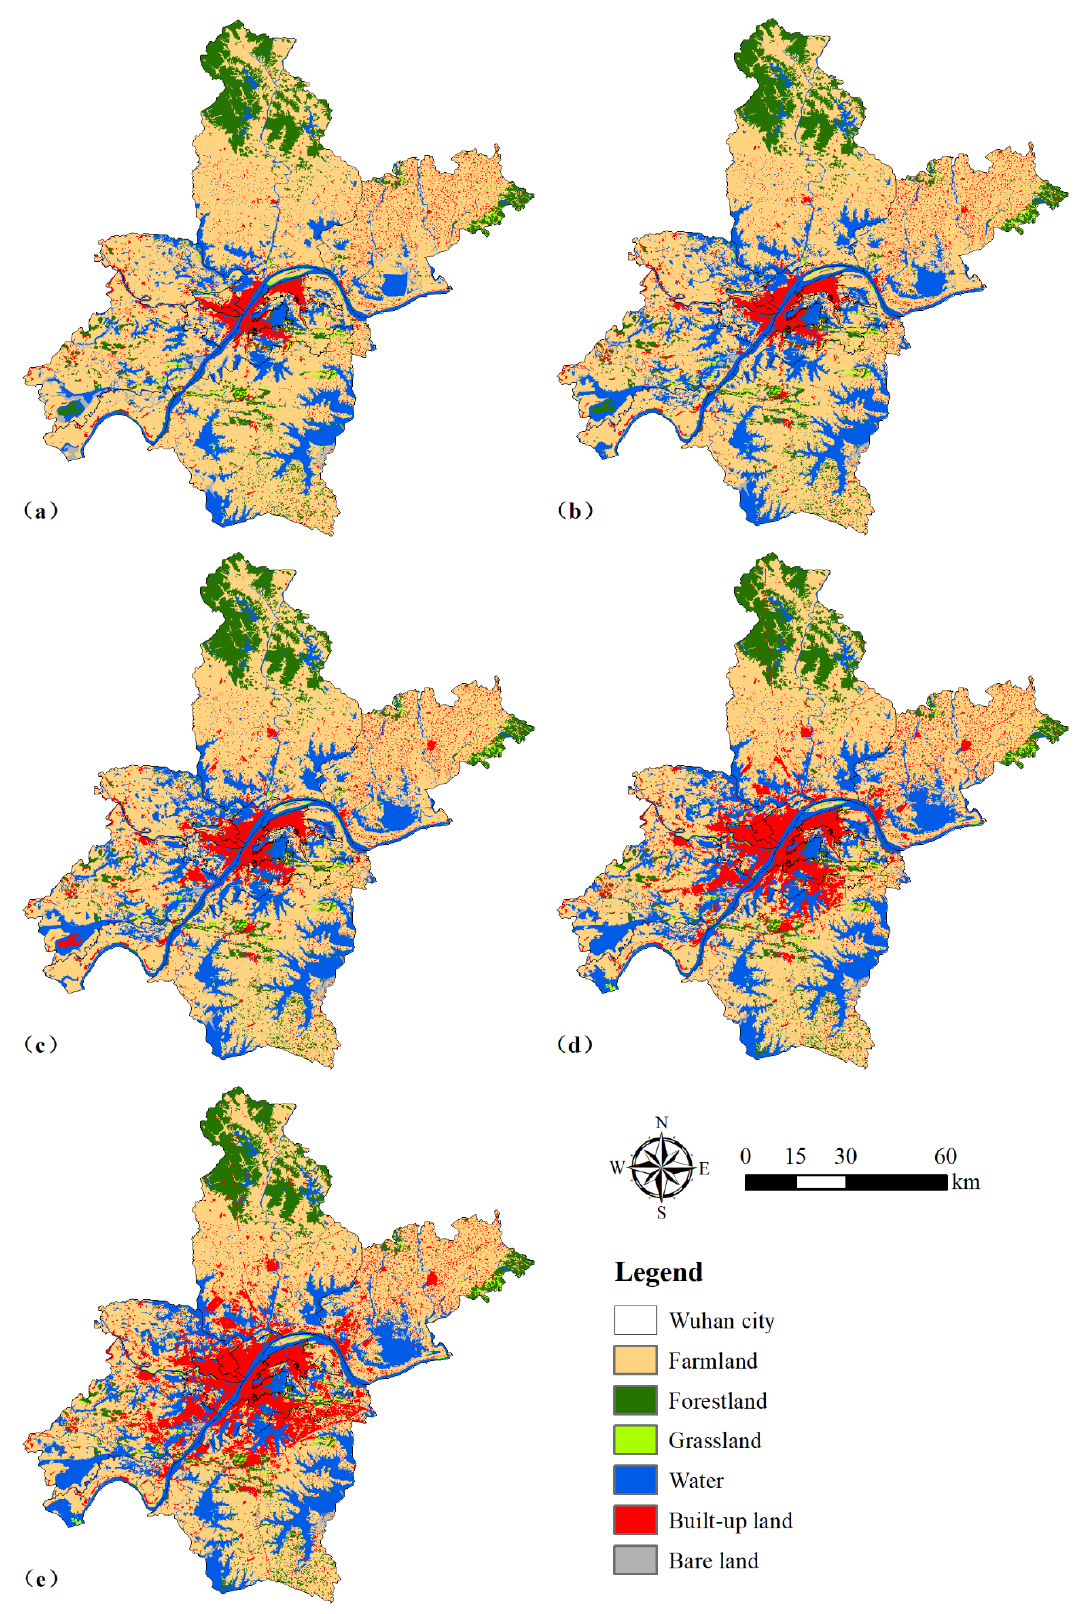
Figure 2. Spatial distribution maps of the land use types in 1980 ( a ), 1990 ( b ), 2000 ( c ), 2010 ( d ), and 2020 ( e ) in Wuhan city, China.